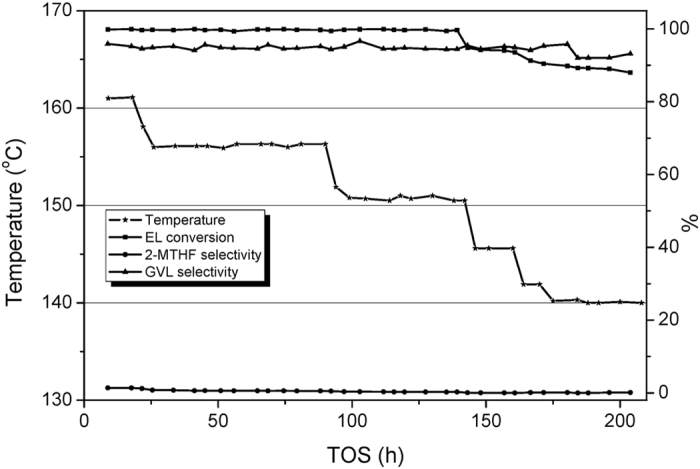
The effect of temperature on the Cu/Al2O3-SiO2 catalyst performance between 140 °C and 162 °C.